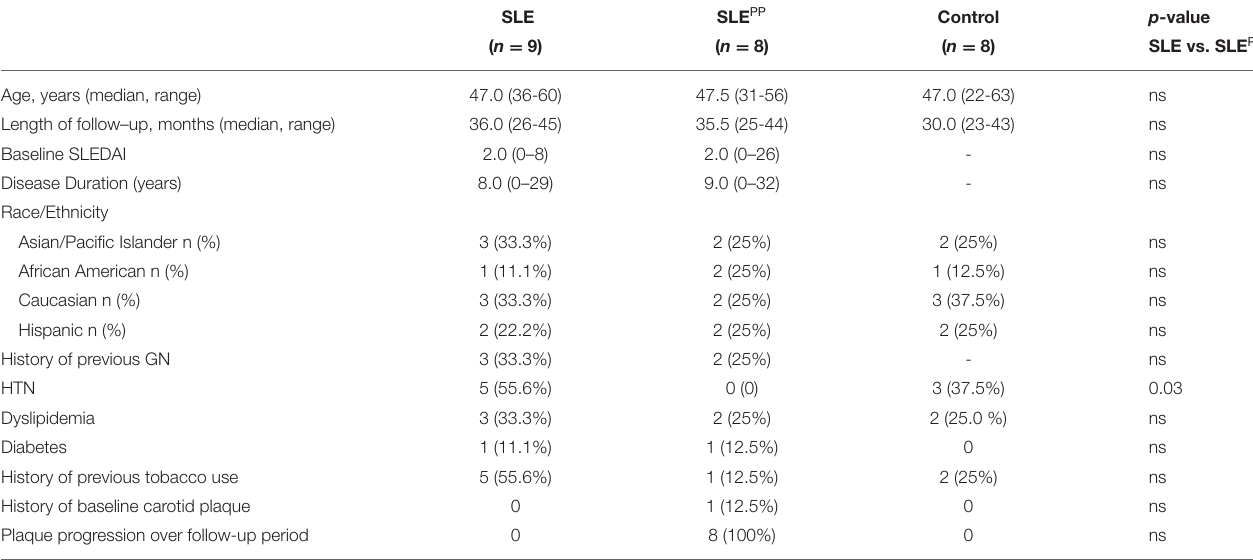
TABLE 1 | Demographics and clinical features of patient cohort used for metabolomic analysis.